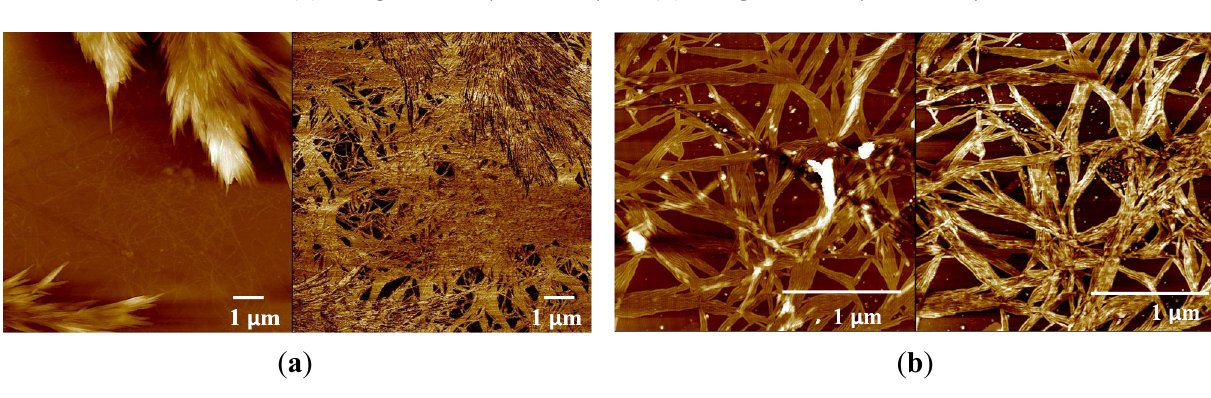
Figure 3. TM-AFM height (left) and phase (right) images of curdlan. Images were obtained by depositing the glucan from a 10 mg/L 5 mM NaOH aqueous solution, pH 11.75, onto mica and scanned in air: ( a ) images of 10 μ m × 10 μ m; ( b ) images of 2.5 μ m × 2.5 μ